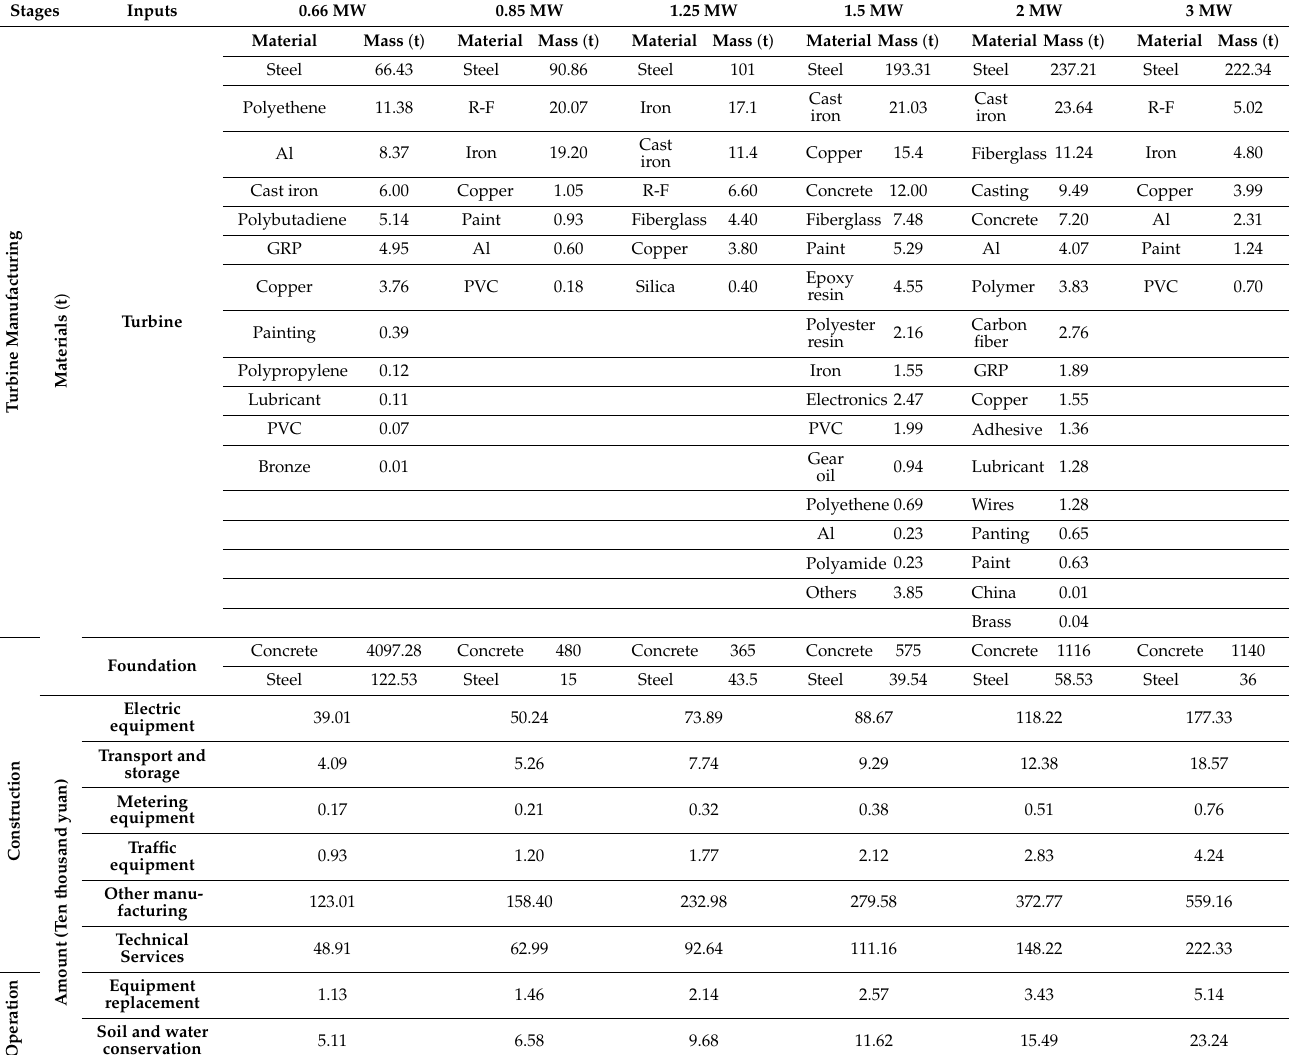
Table 1. Material inventory for six types of wind